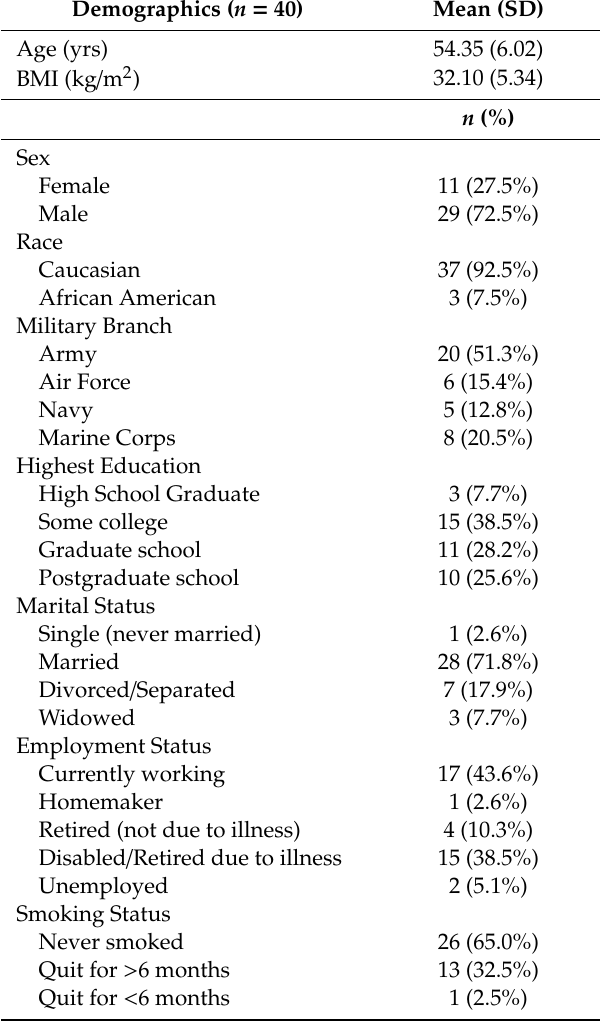
Table 2. Descriptive characteristics of study population at